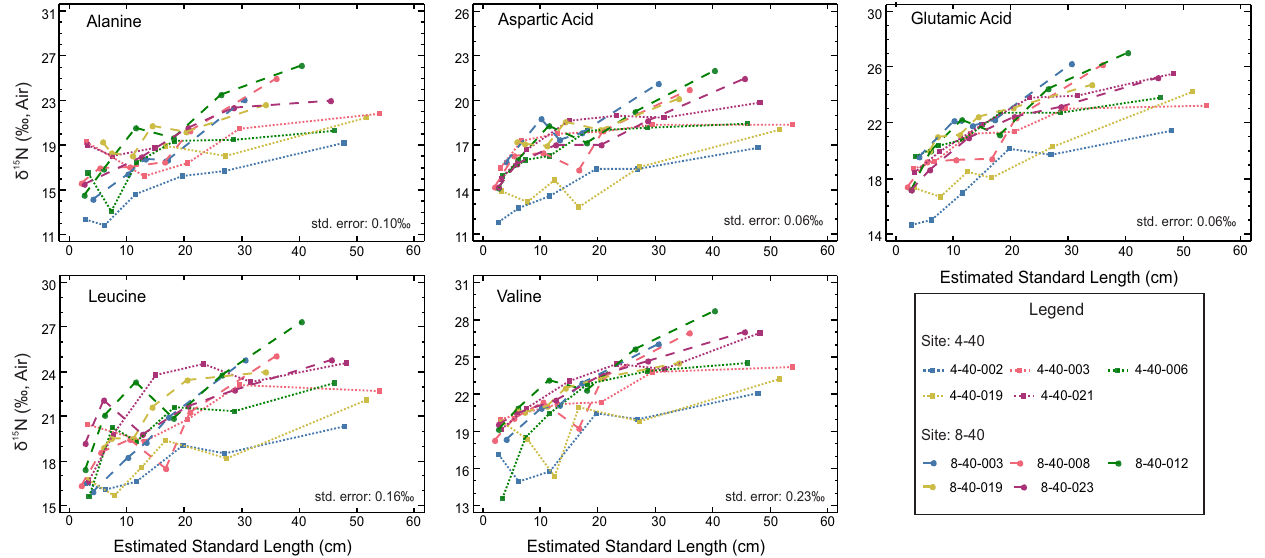
Fig 1. Trophic AAs at estimated fish lengths. Each line represents an individual. Squares are Red Snapper from SL 4–40 and circles are Red Snapper from SL 8–40. Standard error is from Table 1. Not all AAs have a standard error because not all AA present in eye lens protein were able to be measured in muscle